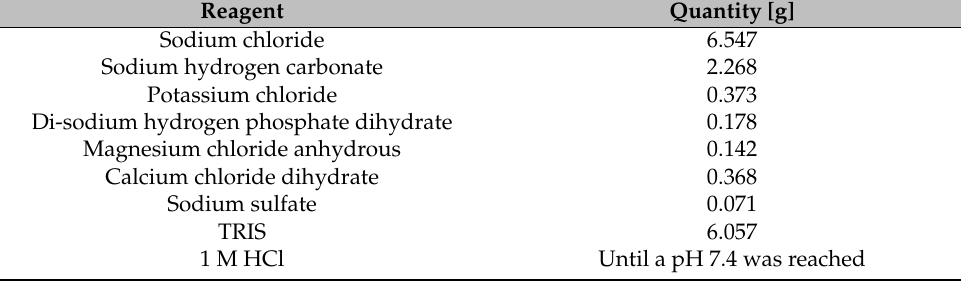
Table 1. Composition of TRIS-buffered simulated body fluid (SBF)